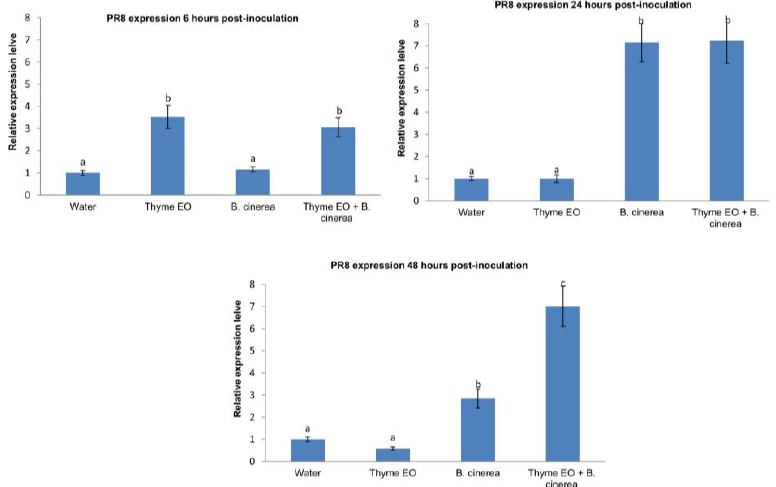
Figure 2. Expression of pathogenesis-related gene PR-8 in apple fruit in response to wounding, thyme essential oil, and B. cinerea at different time points (6 h, 24 h, and 48 h). Vertical lines represent the standard error for the average of three biological replicates. Different letters above the columns indicated a significant difference determined by Duncan’s multiple comparison test ( p < 0.05).